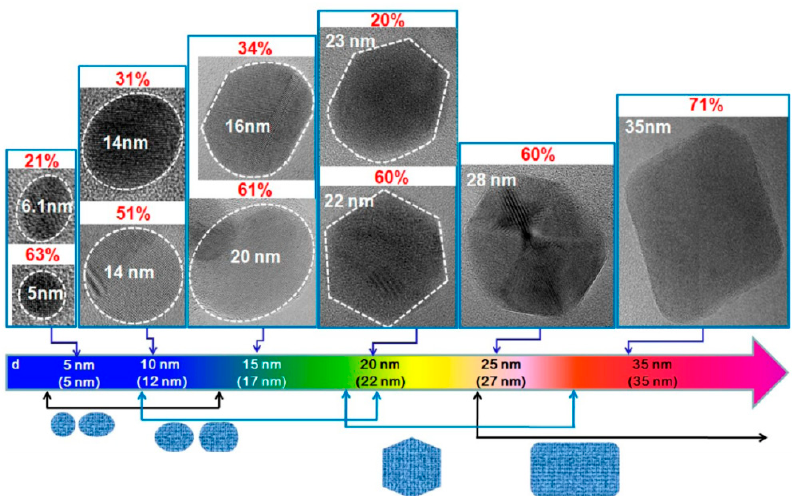
Figure 2. HRTEM images of GQDs reporting their major shapes and the corresponding popula- tions (p) with the increasing average sizes. The dotted lines indicate the region of a GQD, and p is defined as the ratio of number of GQDs with a major shape for each average size. Reprinted with permission from Ref. [35]. Copyright 2012, American Chemical Society.